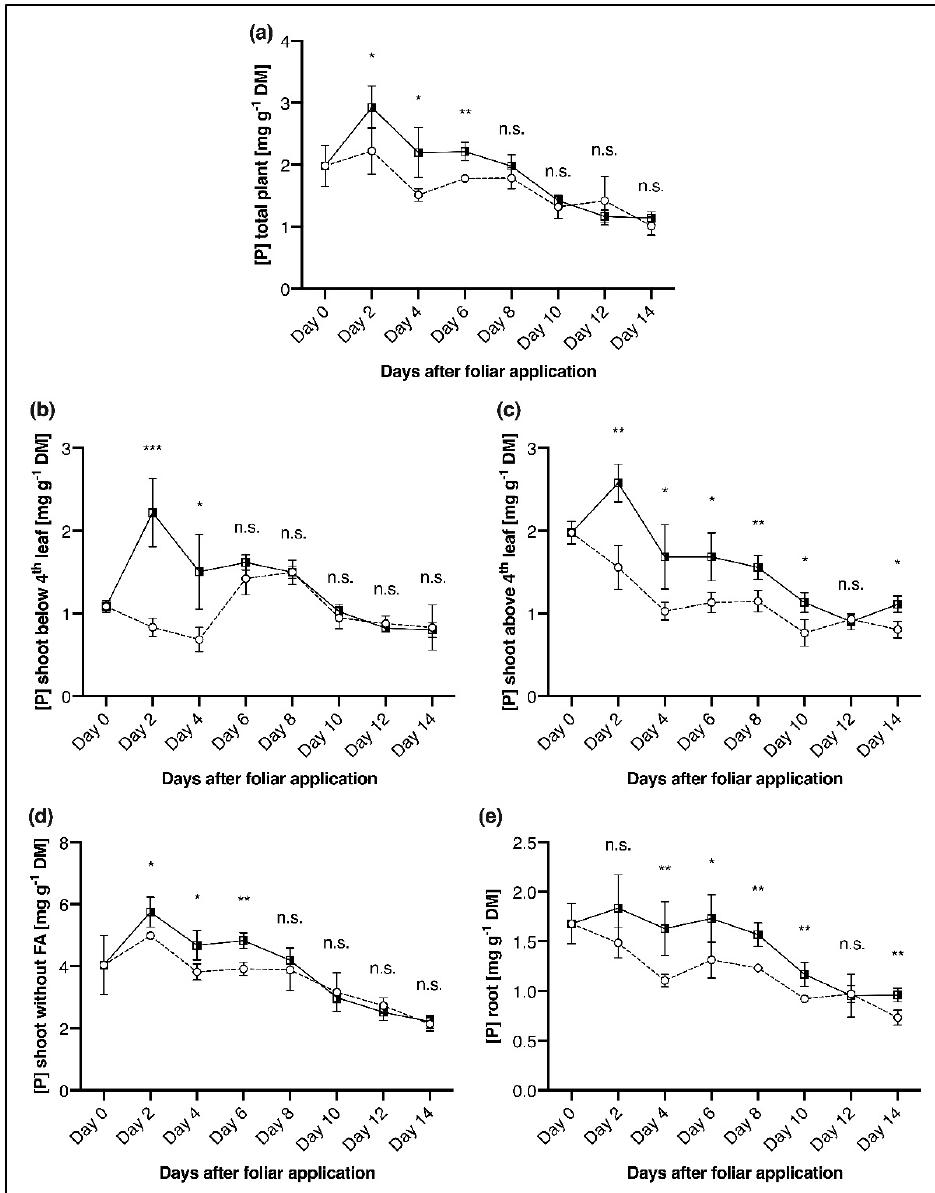
Figure 1. Total phosphorus concentration [P] of different maize plant tissues, analysed over a period of 14 days after foliar P spraying (applied at day 0). Comparison of P deficient control plants (P def - control, ) and P deficient plants sprayed with P (P def + FA, ). ( a ) total plant, ( b ) shoot below the 4th leaf (4th leaf was the youngest fully emerged leaf), ( c ) shoot above the 4th leaf, ( d ) shoot without foliar application—leaves that were still rolled up and encased by other leaves at the time of foliar application and thus did not receive direct contact with the foliar fertiliser, ( e ) root. Datapoints represent means + standard deviation ( n = 4). * = p ≤ 0.05; ** = p ≤ 0.01; *** = p ≤ 0.001; n.s. = not significant ( t -Test).